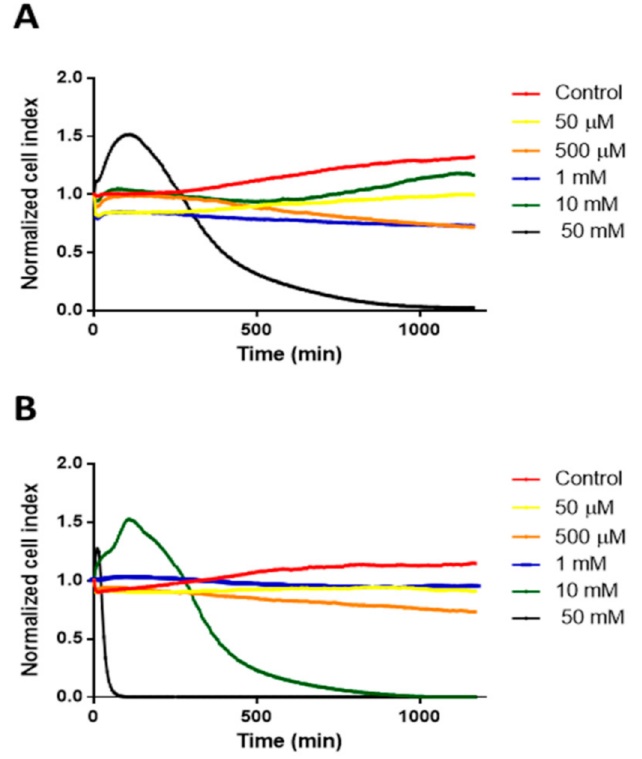
Figure 1. Cytotoxicity of HPBCD ( A ) and RAMEB ( B ) on Caco-2 cells as a function of time, measured by RTCA method.